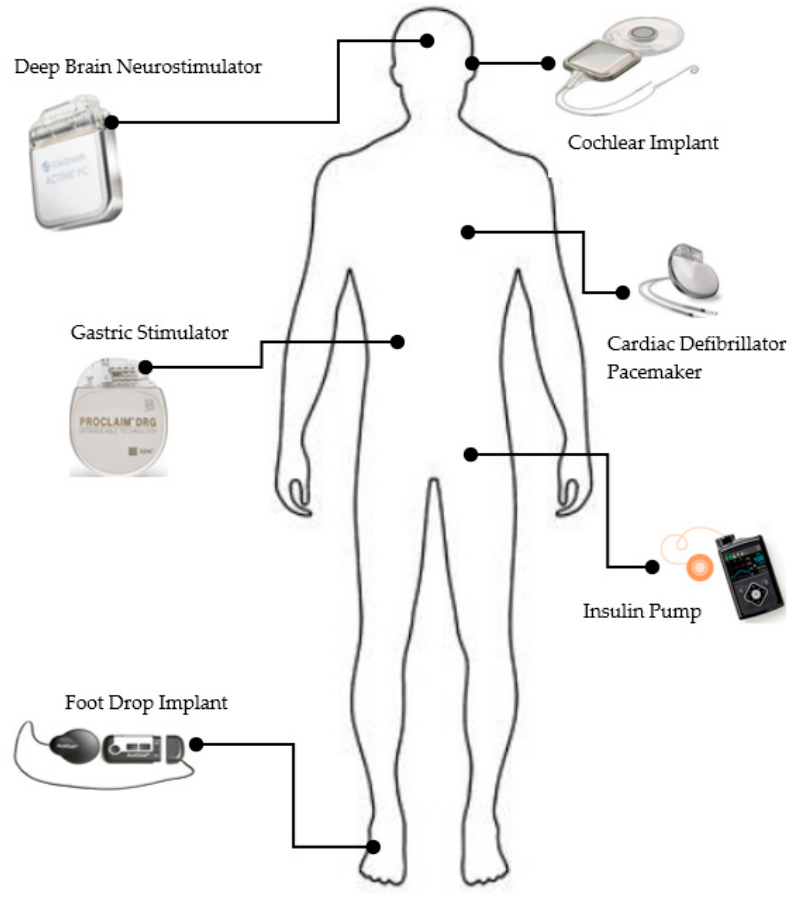
Figure 1. Overview of a patient’s body with IoT medical sensors.